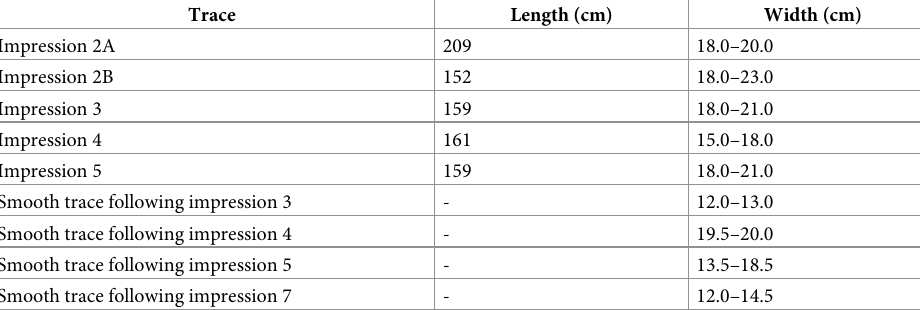
Table 2. Dimensions of the better-preserved large impressions and selected smooth